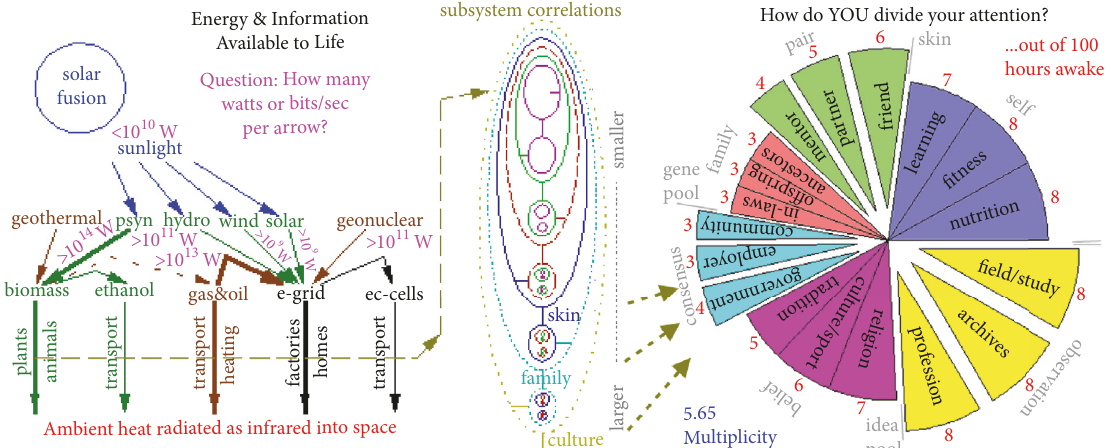
Figure 1: Available work flows (left) power a correlation hierarchy (center) that supports life’s everyday complexity. At right, in this context, we illustrate one way to report results of an attention-slice survey for human individual, as well as community, task-layer multiplicity. L6 10k with a uniform task distribution L6 10k with half f3+f4 and quarter f5+f6